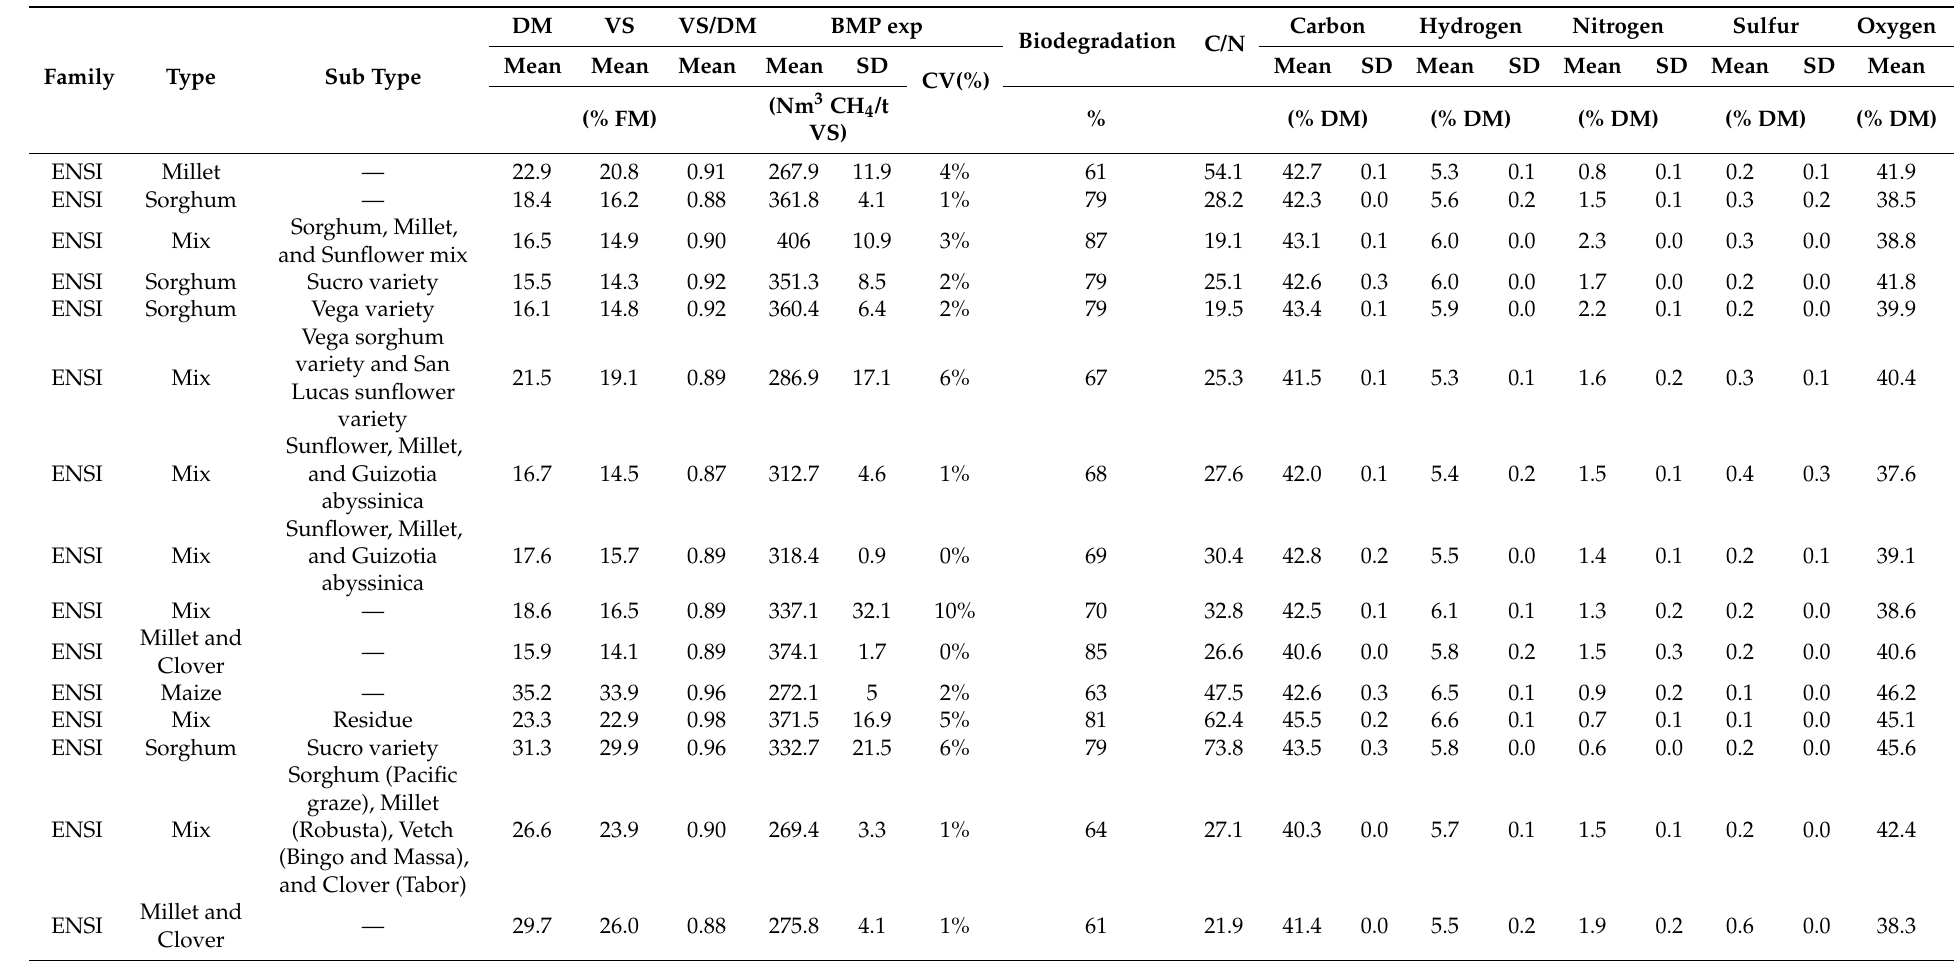
Table A1. Description of the substrates analyzed within the families, where SD is standard deviation, DM is dry matter, FM is fresh matter, VS is volatile solids,